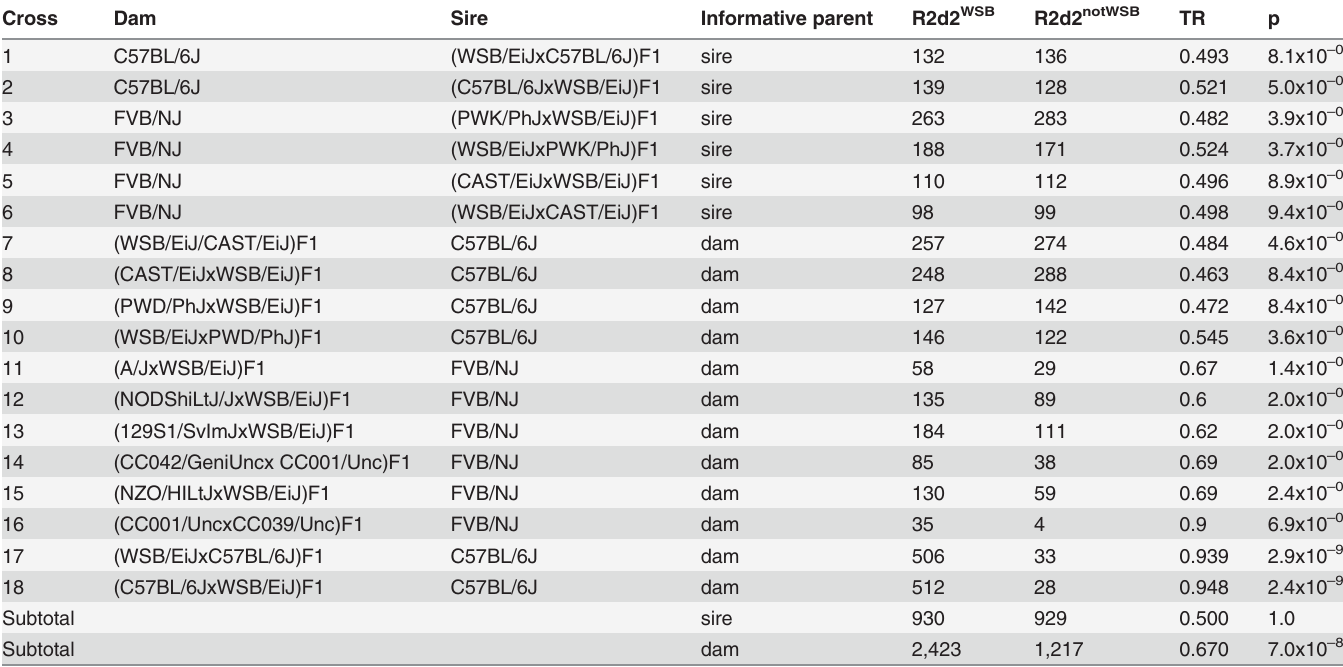
Table 1. Transmission ratios in the progeny of R2d2 WSB/notWSB heterozygous F1 hybrid sires and